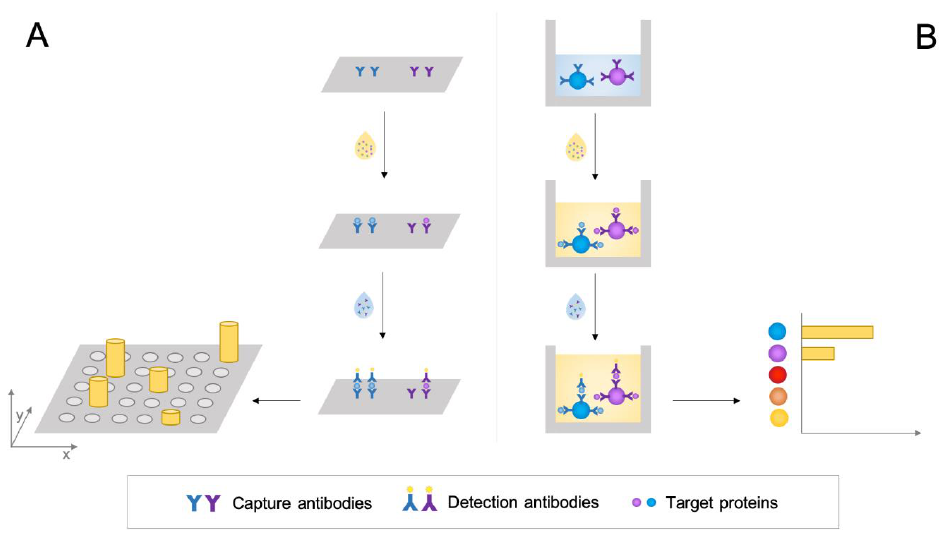
Figure 2. Multiplexed immunoassay systems: ( A ) planar-based assays and ( B ) microbead-based suspension